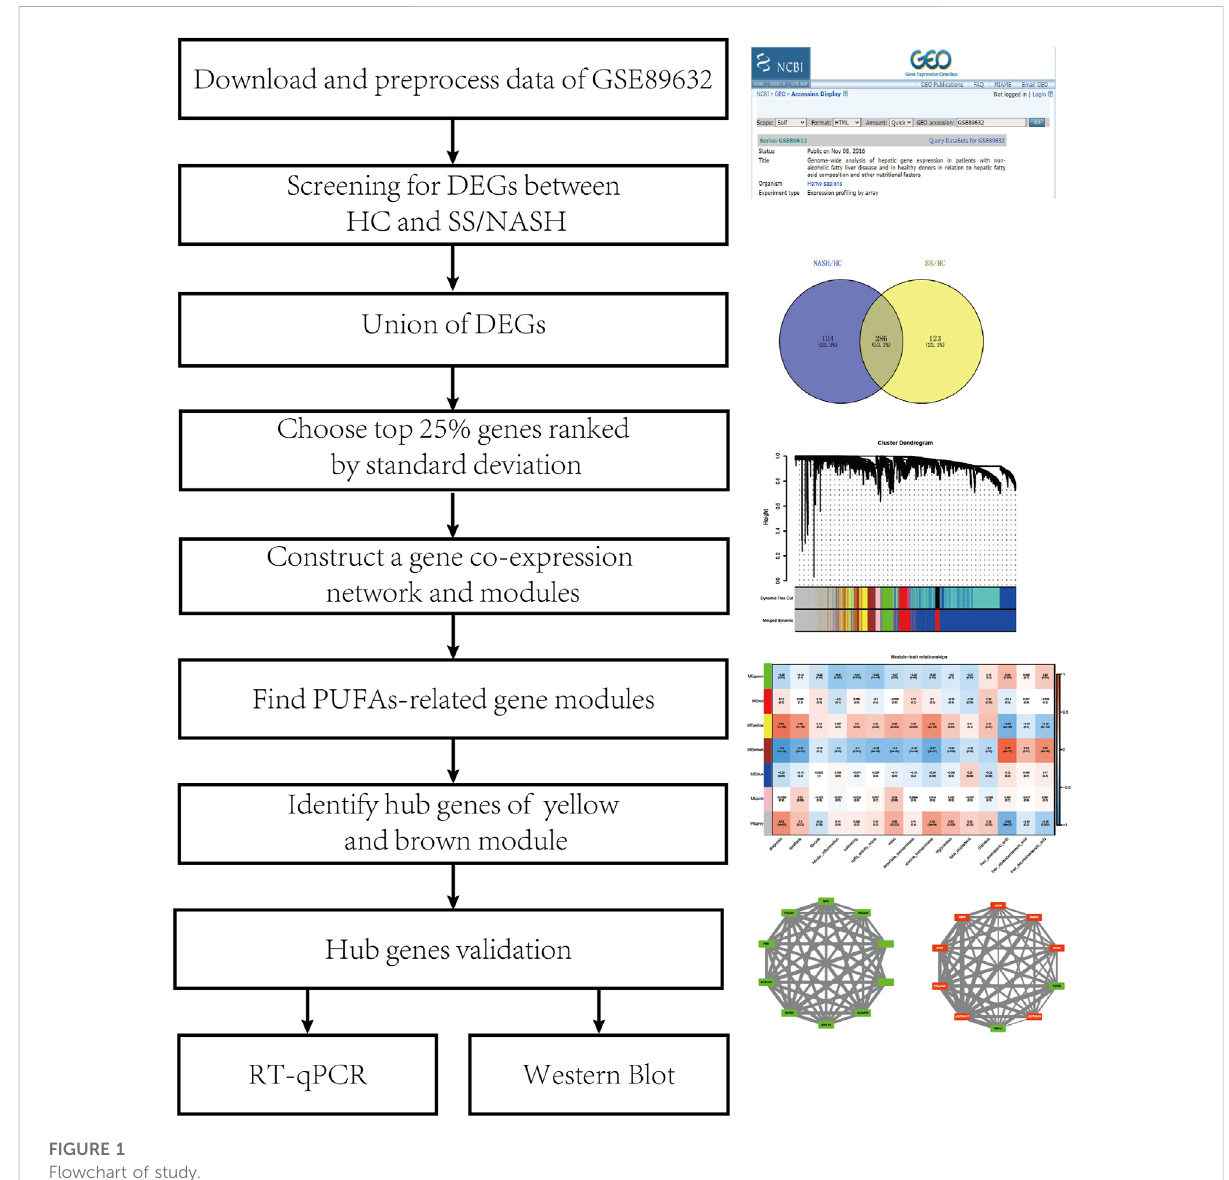
FIGURE 1 Flowchart of